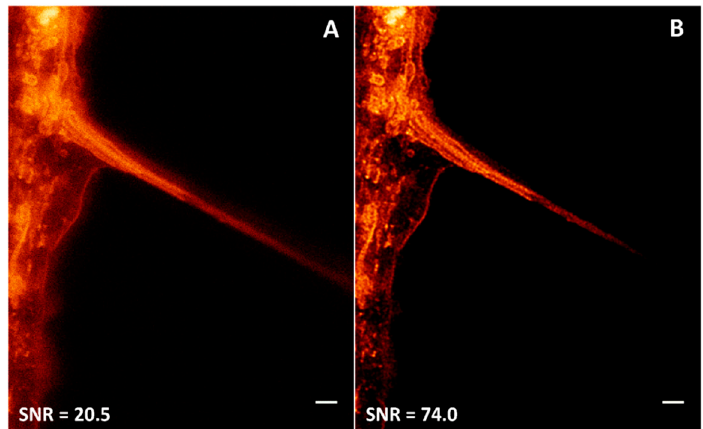
Figure 19. Improvement of Signal-to-Noise Ratio (SNR) in STED images through deconvolution. Alexa 488-WGA-labeled Tunneling NanoTubes in living PC12 cells were observed through CW gated STED (for experimental procedures, please see [122]). ( A ) Raw image; ( B ) Deconvolved image through Huygens professional © 18.04. Values of SNR were determined through ImageJ software (Rasband, W.S., U.S. National Institutes of Health, Bethesda, MD, USA, 1997–2016). Scale bar: 1 µm.